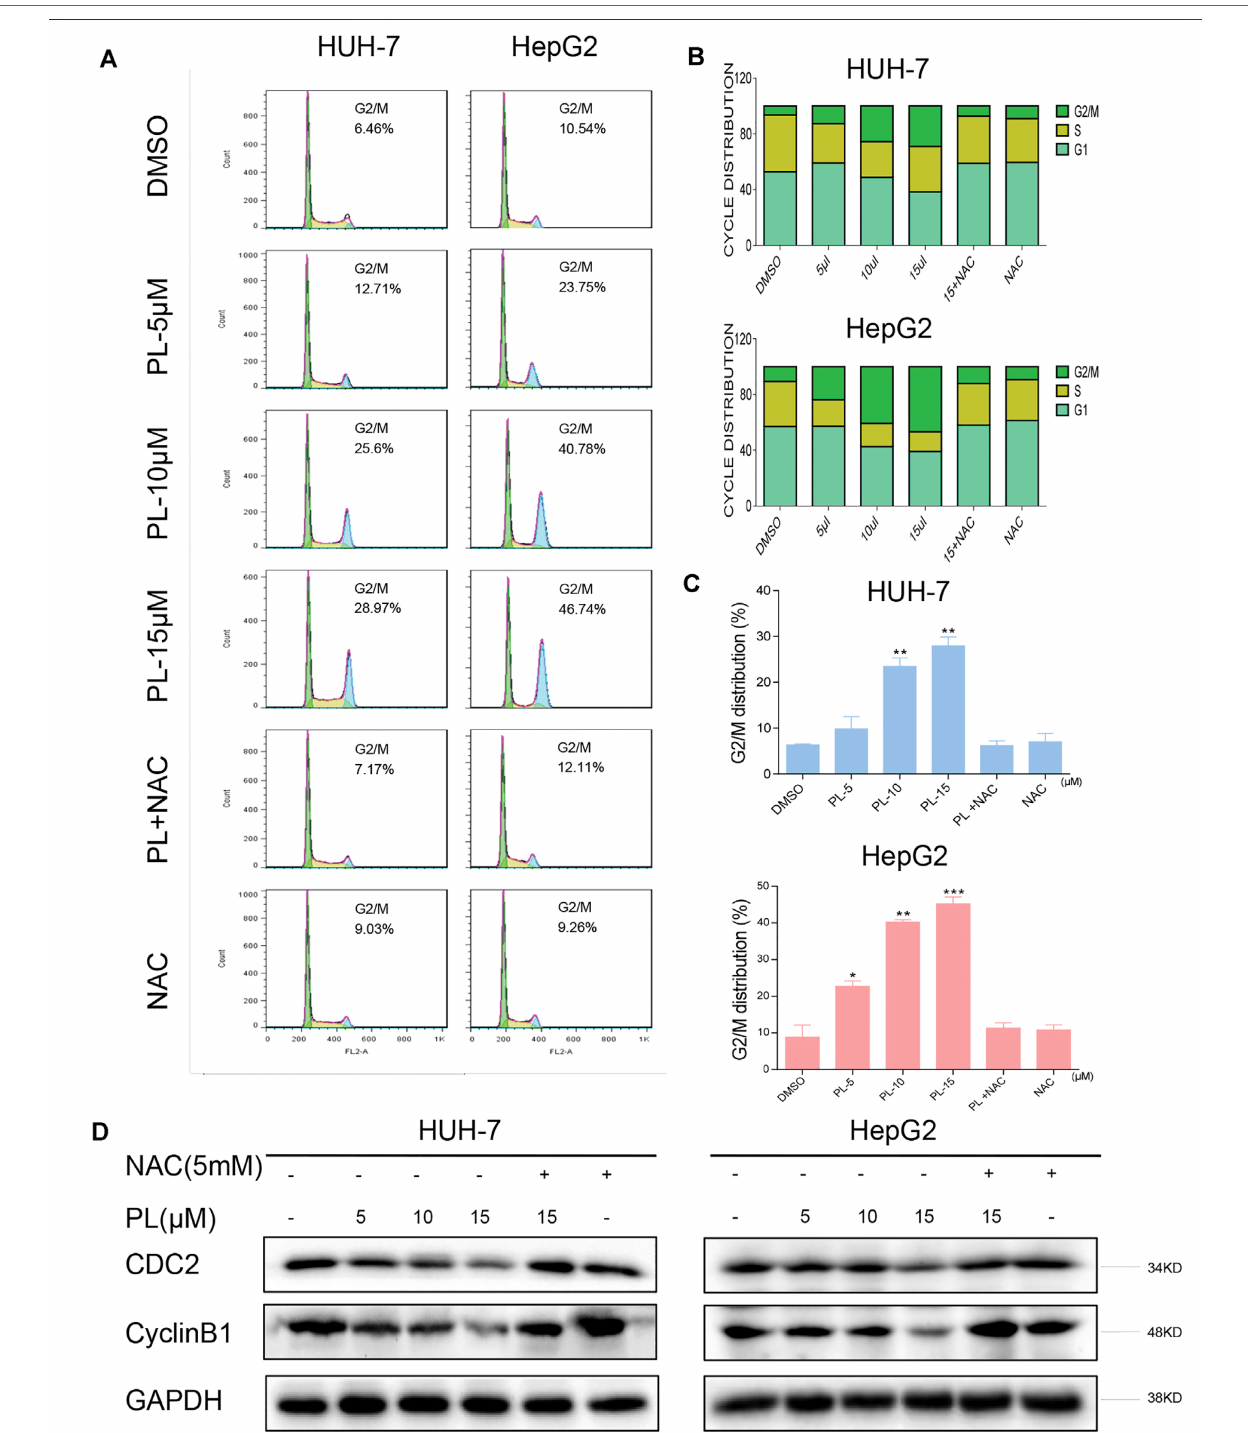
FIGURE 3 | PL induces -induced cell cycle arrest is dependent on intracellular ROS generation in HCC cells. (A) HUH-7 and HepG2 cells were preincubated with or without 5 mM NAC for 2 h before exposure to PL at the indicated concentrations for 16 h. The cell cycle distribution was analyzed by flow cytometry. (B and C) Representative histogram from the cell cycle analysis shown in panel (A) . (D) Expression of G2/M phase-related proteins CyclinB1 and CDC2 in HCC cells exposed to the indicated concentration of PL with or without NAC (5 mM) for 20 h. GAPDH was used as an internal control. Data represent similar results from three independent experiments. Error bars represent the S.E.M. of triplicate experiments (*p < 0.05, **p <